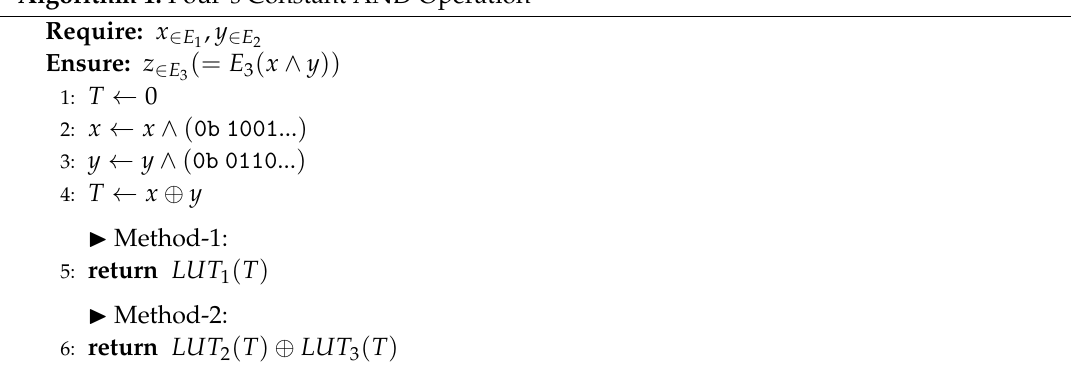
Algorithm 1: Pour’s Constant AND Operation